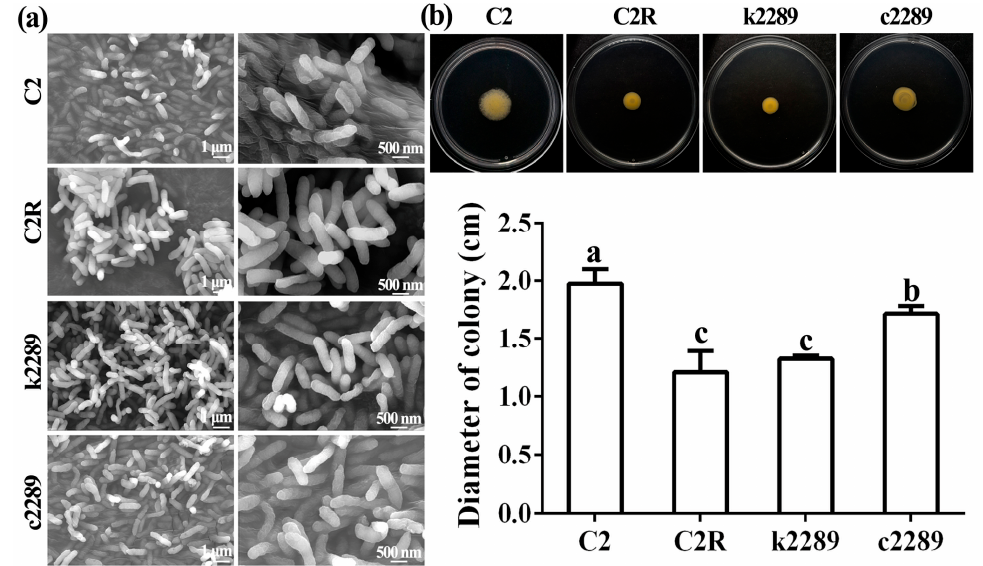
Figure 6. Mutation of glycosyltransferase gene alters the bacterial morphology and motility. ( a ) SEM images about cell surface morphology of the C2, C2R, k2289 and c2289. ( b ) Motility of C2, C2R, k2289 and c2289. Colony diameter (cm) was presented as means ± standard errors ( n = 3). Columns with different letters are significantly different according to LSD test ( p < 0.05).